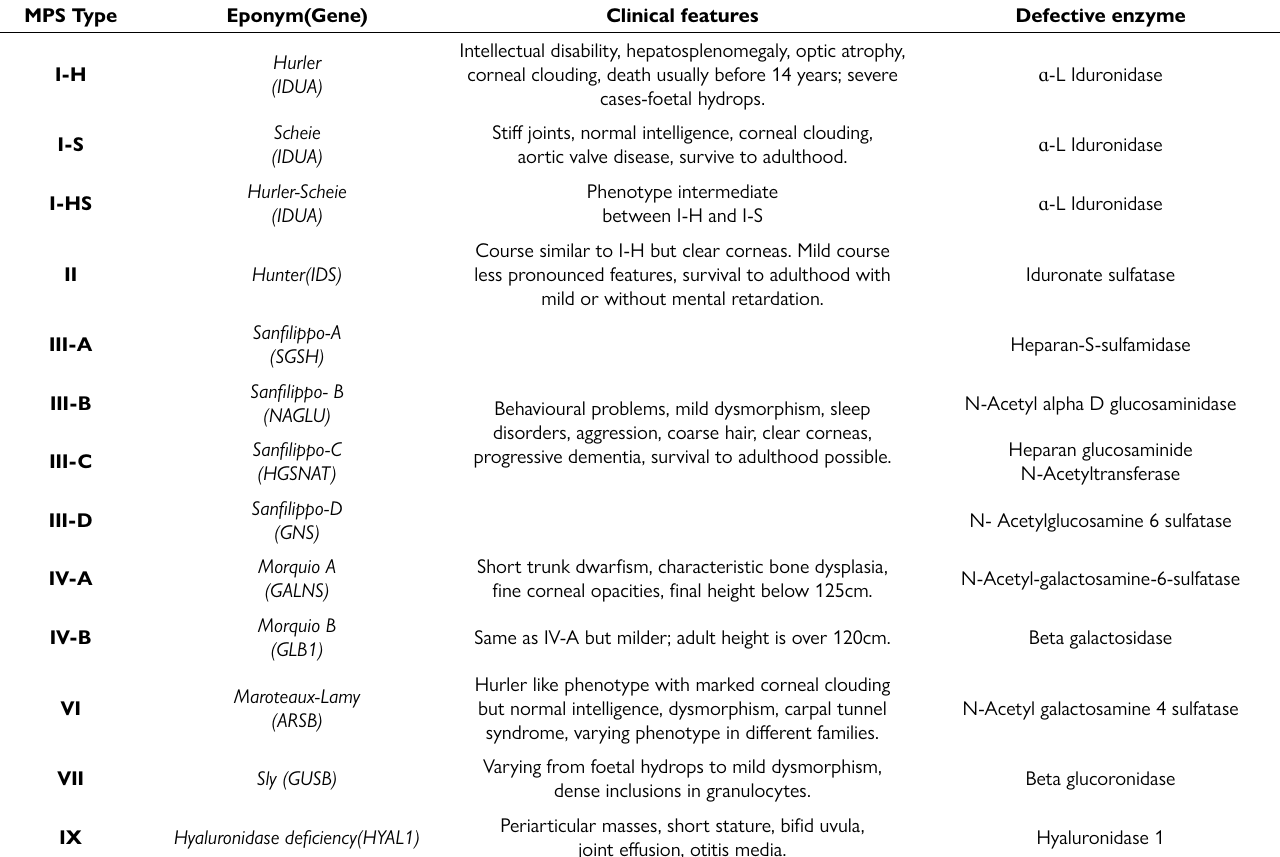
Table 1. Types of mucopolysaccharidoses (MPS) and clinical features